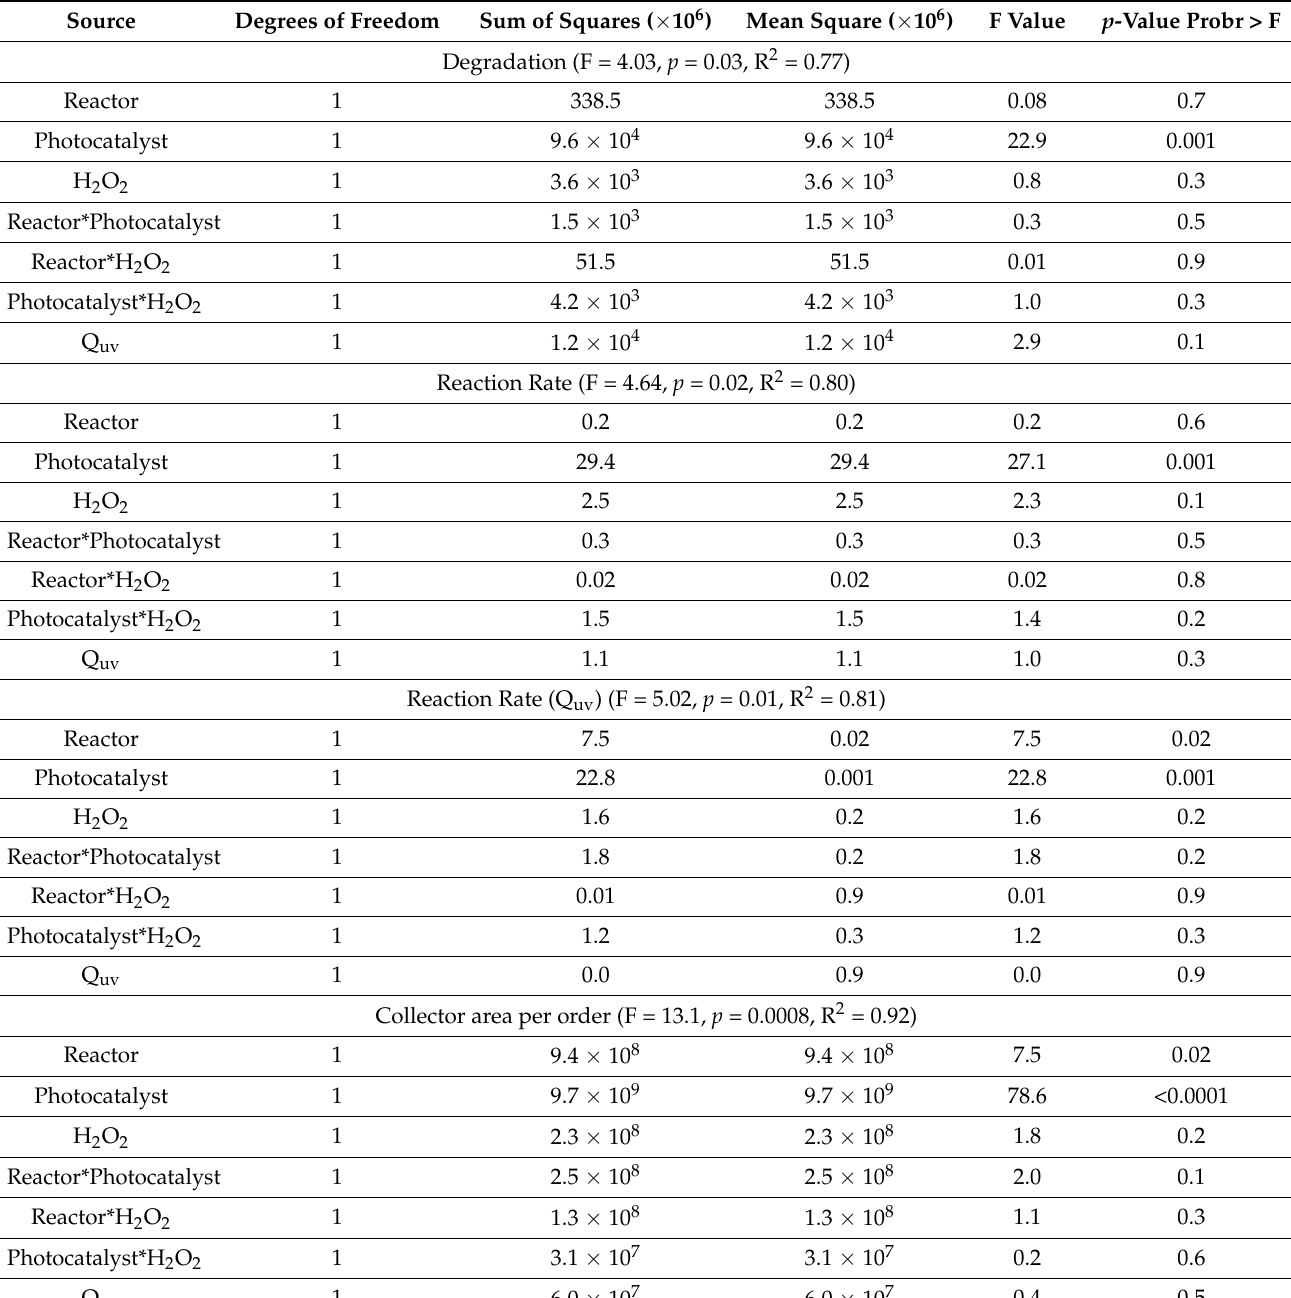
Table 3. Summary of Analysis of Covariance (ANCOVA) for phenol-degradation